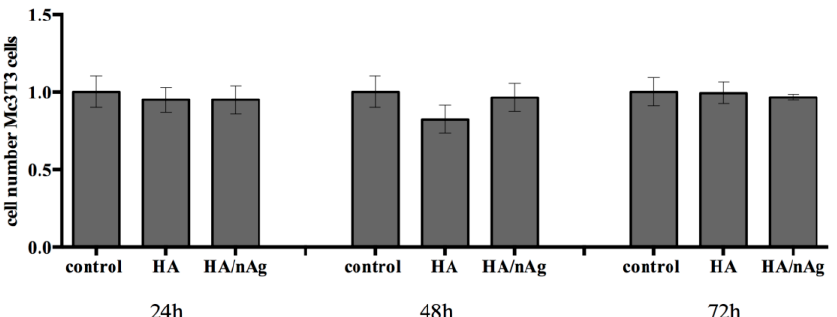
Figure 8. Tali image cytometry results performed on MC3T3-E1 cells to measure cell viability.